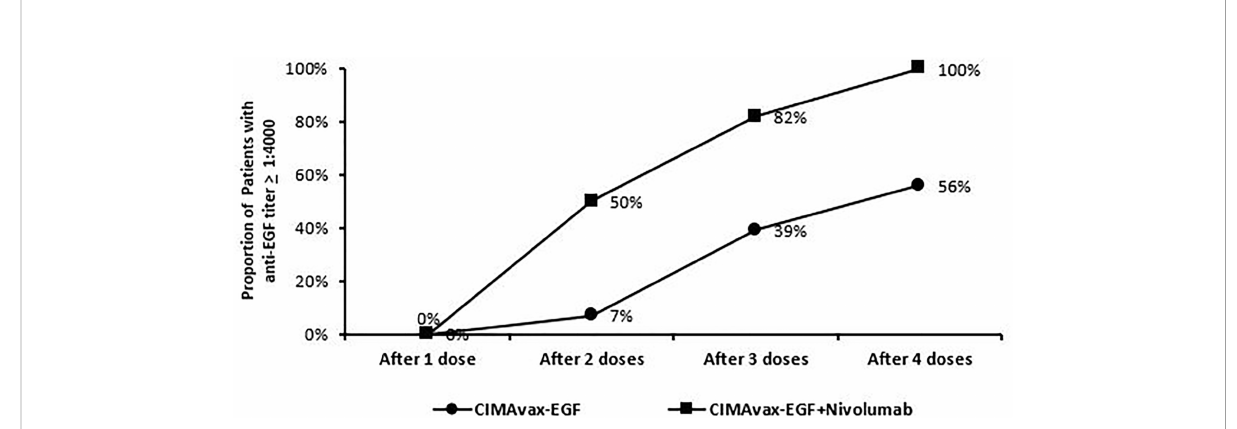
FIGURE 1 Trend of patients dosing and achieving anti-EGF titer ≥ 1:4,000. Good anti-EGF antibody response ( ≥ 1:4,000) elicited at earlier time points in more patients receiving CIMAvax-EGF in combination with nivolumab compared to historical